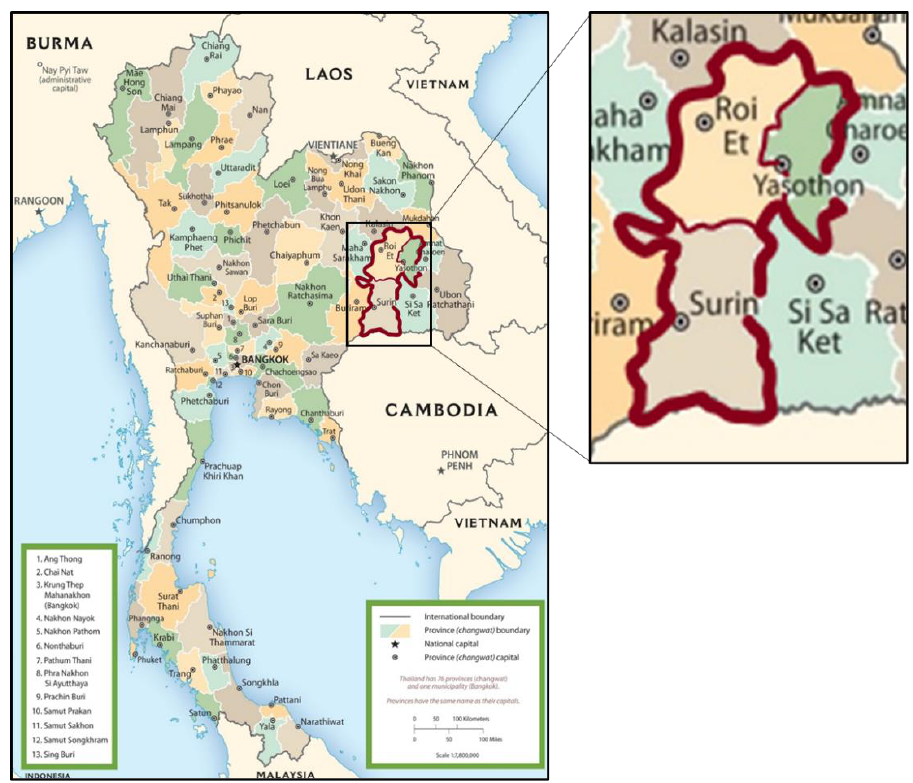
Figure 1. Sampling areas of three contiguous provinces in Thailand for Thai Hom Mali rice (THMR) samples. The right figure is the enlargement of Yasothon province (YP), Roi Et province (RP), and Surin province (SP).